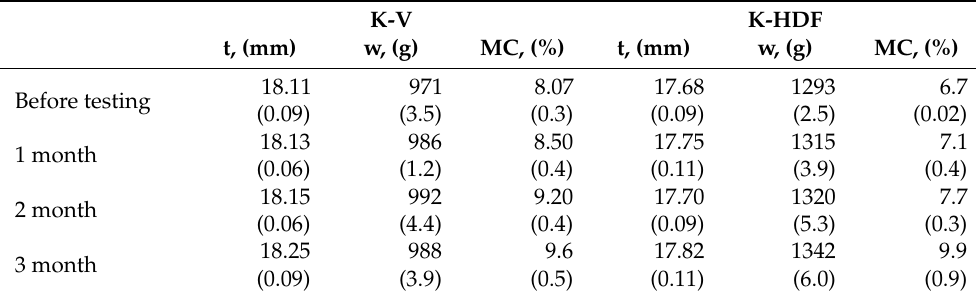
Figure 3. Variation of the environmental parameters: ( a ) in the kitchen; ( b ) in the bathroom. Table 3. Variation of the blockboards’ physical parameters during their exposure in the kitchen conditions (average values recorded for each